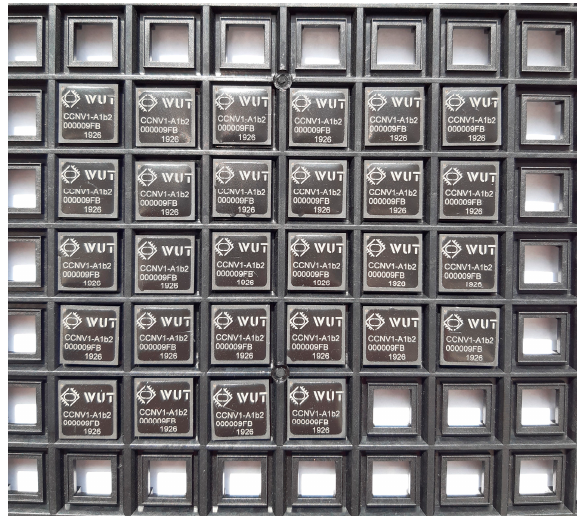
Figure 24. CCNV1-A1 integrated circuit die microphotography.